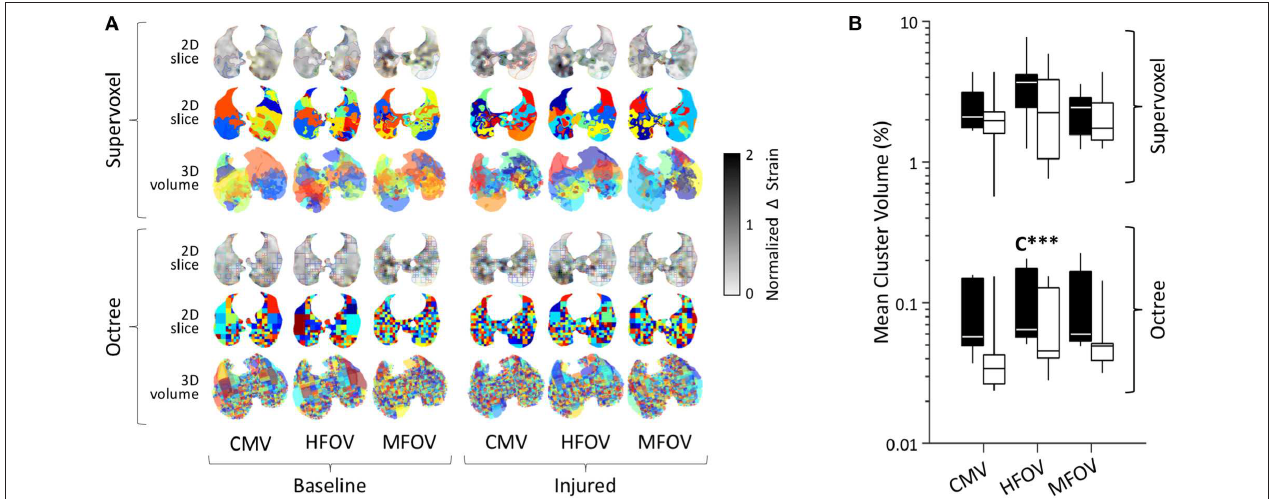
FIGURE 9 | Regional patchiness of intratidal variations in volumetric strain ( 1ε ) during conventional mechanical ventilation (CMV), high-frequency oscillatory ventilation (HFOV), and multi-frequency oscillatory ventilation (MFOV). Regional patchiness was assessed by the size, number, and distribution of regions-of-interest or clusters (randomized colors) obtained by recursive supervoxel or octree decomposition. Examples from a representative subject (A) , and cluster volumes as a fraction of the lung mask (B) represented by box plots showing minimum, maximum, and quartiles across subjects under baseline (black) and injured (white) conditions. Asterisks indicate significance levels (*** p < 0.001) for main effects (C lung =